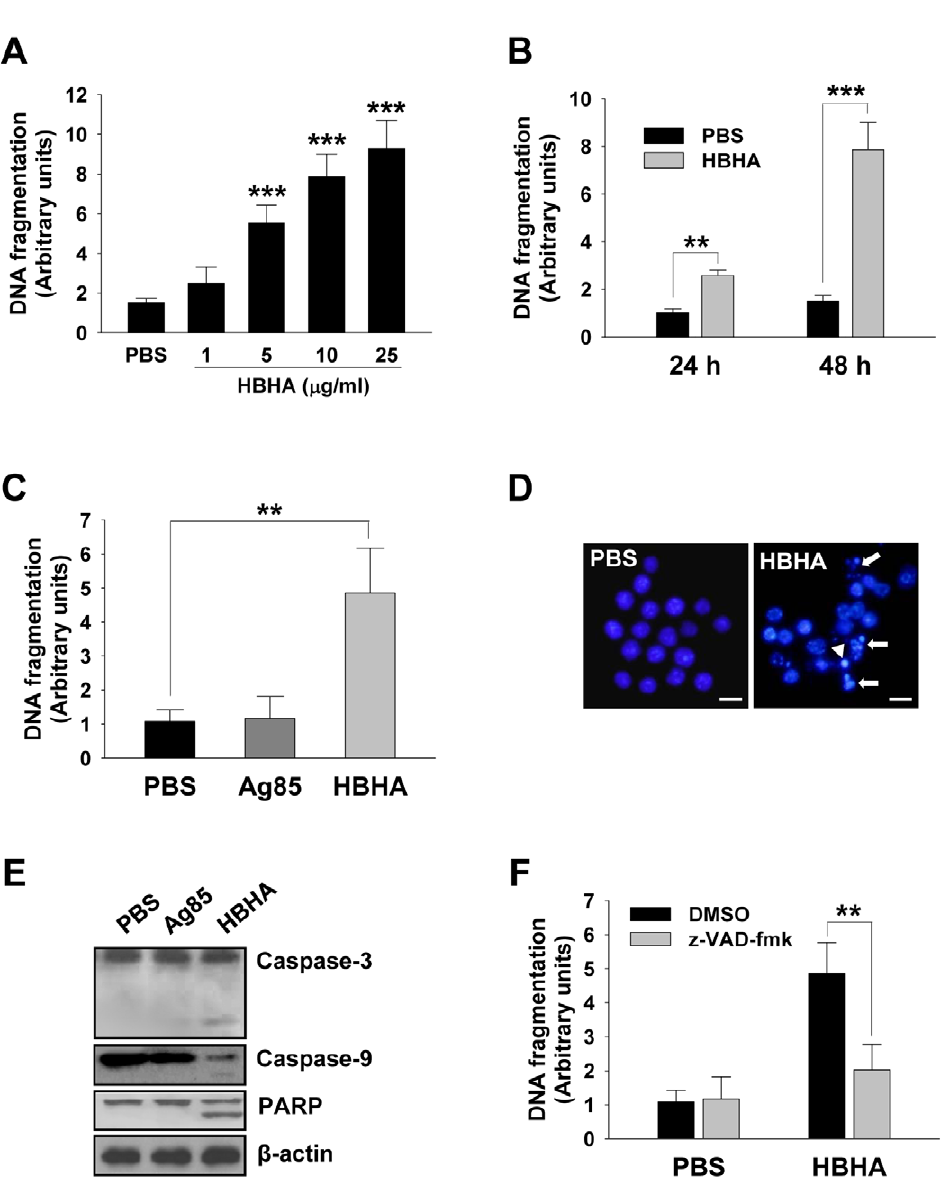
Figure 1. HBHA-induced macrophage apoptosis. ( A,B ) DNA fragmentation of RAW 264.7 cells incubated with the indicated concentrations (A) or 10 m g/mL (B) of HBHA for 24 or 48 h was measured by Cell Death Detection ELISA. ( C ) DNA fragmentation of BMDMs incubated with HBHA (10 m g/ mL) or Ag85 (10 m g/mL) for 48 h was measured by Cell Death Detection ELISA. Values represent the mean OD 405 6 SD of at least three experiments. ** P , 0.01, *** P , 0.001 RAW 264.7 cells treated with PBS versus those treated with HBHA. ( D ) RAW 264.7 cells were treated with HBHA (10 m g/mL) or PBS for 36 h, fixed, and stained with DAPI. Fragmented nuclei are indicated by arrows, and a condensed nucleus is denoted by an arrowhead. Scale bar, 10 m m. ( E ) BMDMs cell lysates exposed to HBHA for 36 h were immunoblotted against caspase-3, caspase-9, and PARP. To confirm equal protein loading, blots were re-probed with an antibody against b -actin. ( F ) BMDMs were incubated with PBS or HBHA (10 m g/mL) in the presence or absence of zVAD-fmk (50 m M). DNA fragmentation was measured as described above. Results are the mean 6 SD of three independent experiments. ** P , 0.01 between cells incubated with HBHA only and those incubated with HBHA + zVAD-fmk.